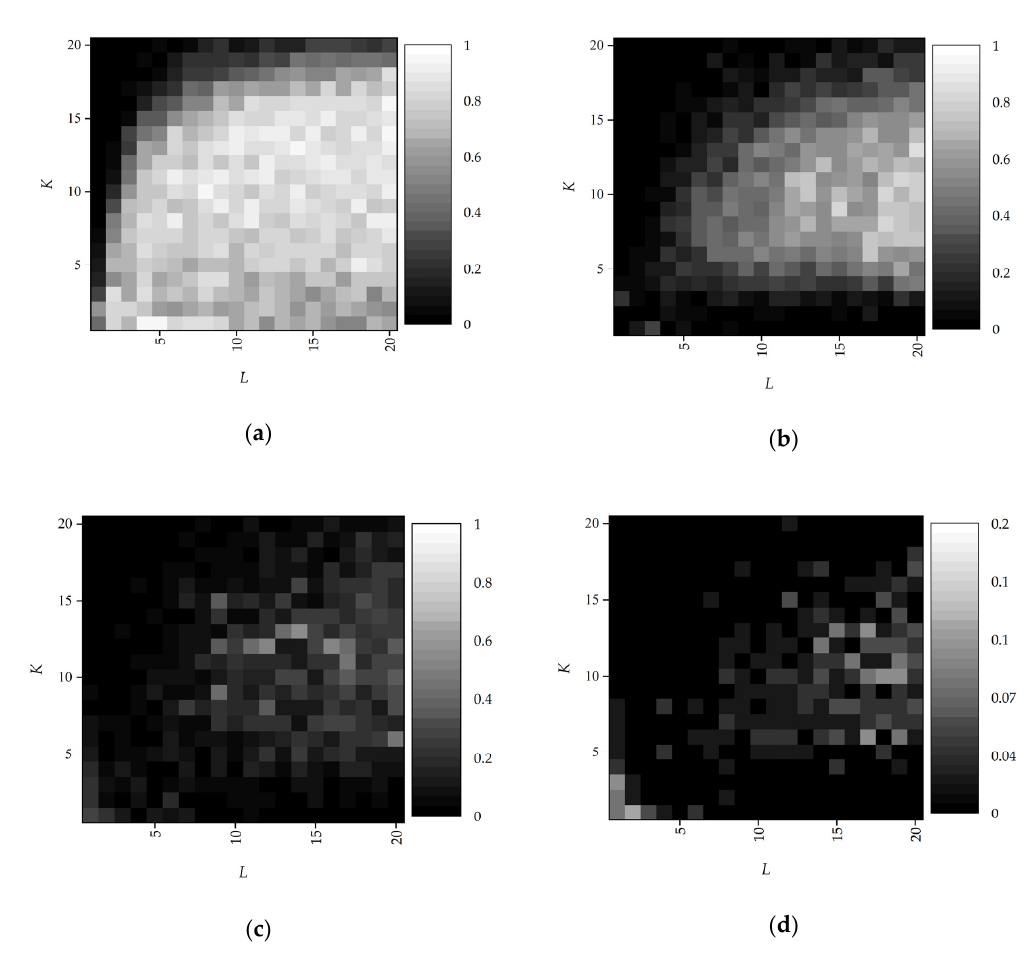
Figure 2. Phase transitions of the proposed initialization algorithm with different noise levels: ( a ) noise free; ( b ) σ = 0.01; ( c ) σ = 0.02; ( d ) σ = 0.03. The gray bar denotes the success rate.